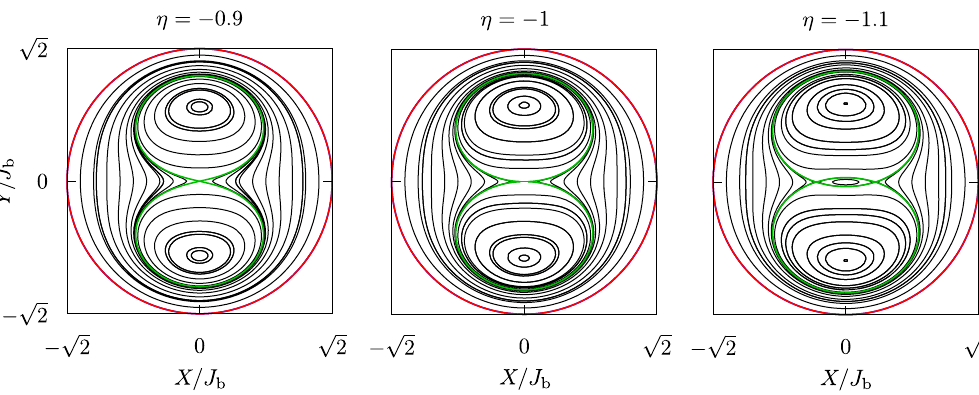
FIG. 4. Details of the transition between the phase-space topology ð B Þ and ð C Þ shown in Fig. 3 for α ¼ 2 . We remark that a bifurcation phenomenon occurs at the origin at η ¼ − 1